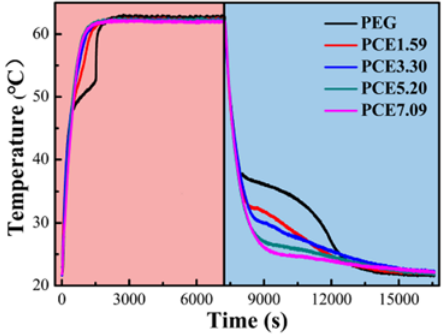
Figure 8. Time-temperature curves of PEG and PCE-CPCMs during the heating and cooling processes.